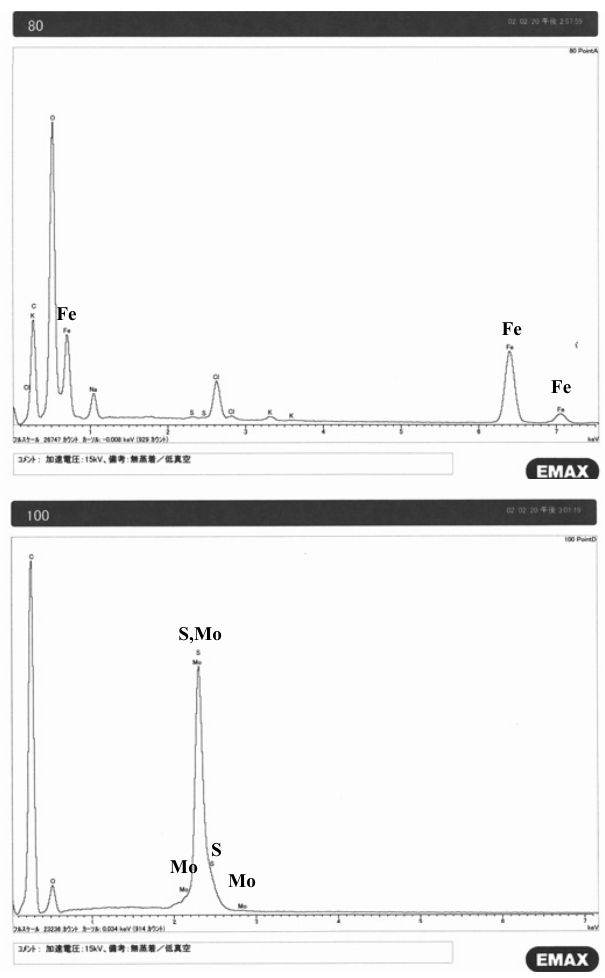
Fig. 5. – Specific peaks of the Fe atom at point A (Fig. 3) and S and Mo atoms at point D (Fig. 3) detected in the complexes of chloro- phyll with low molecular weight proteins in the 80 % (A) and 100 % (B) acetone-soluble fractions by using an SEM/EDX